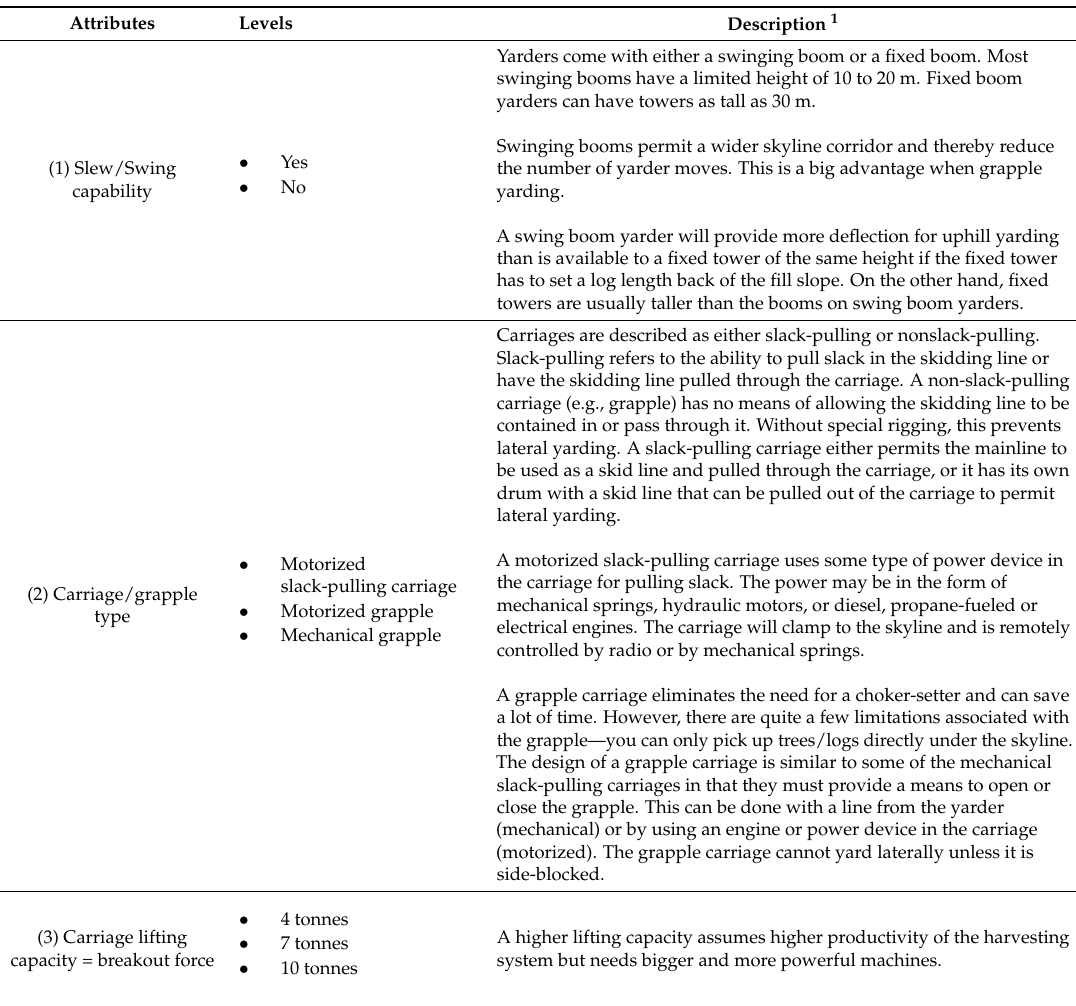
Table A1. Description of attributes and levels for the design of a new